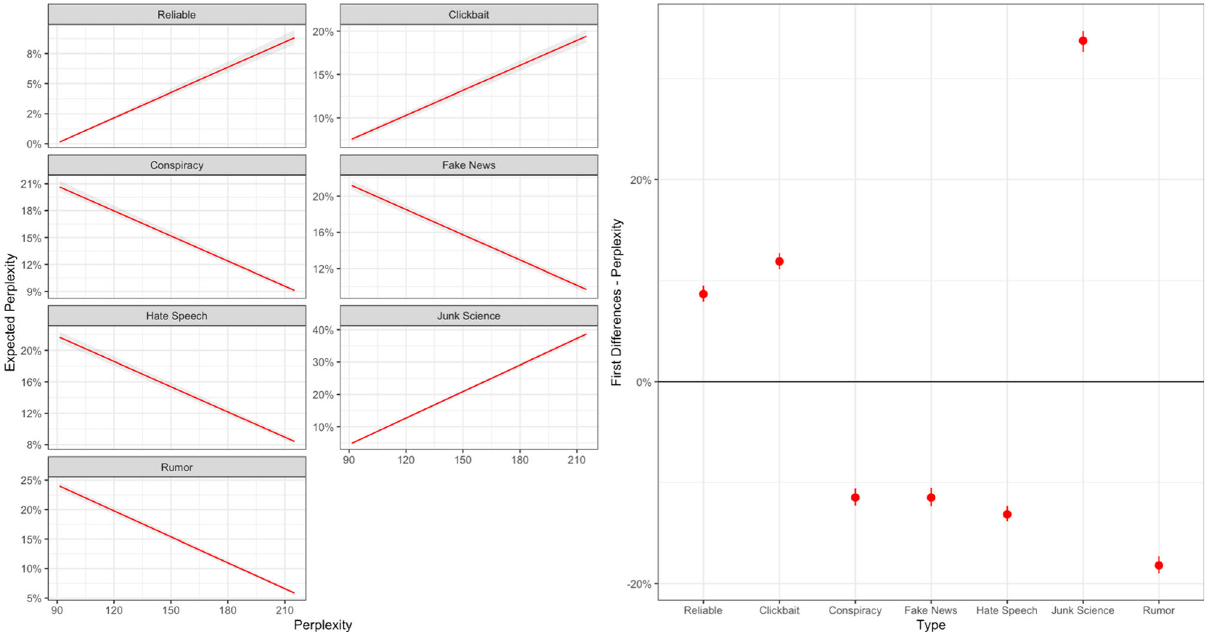
Fig. 6 First differences of the multinominal logit model − Perplexity.